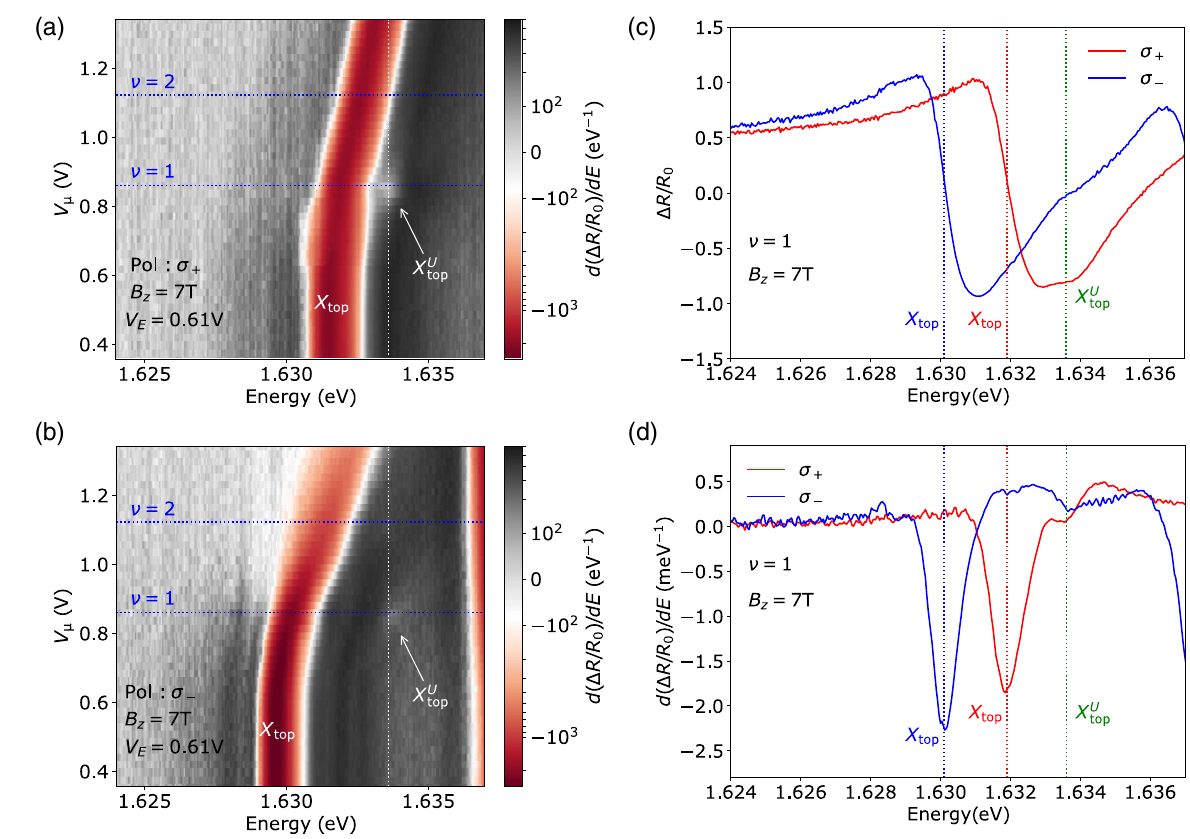
¼ 7 T. (a),(b) V μ dependence of differential z